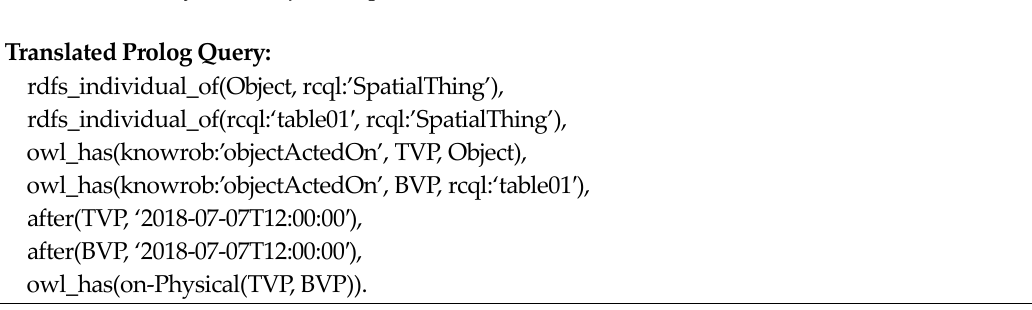
Figure 14. Illustration of translation for spatio-temporal query pattern one.